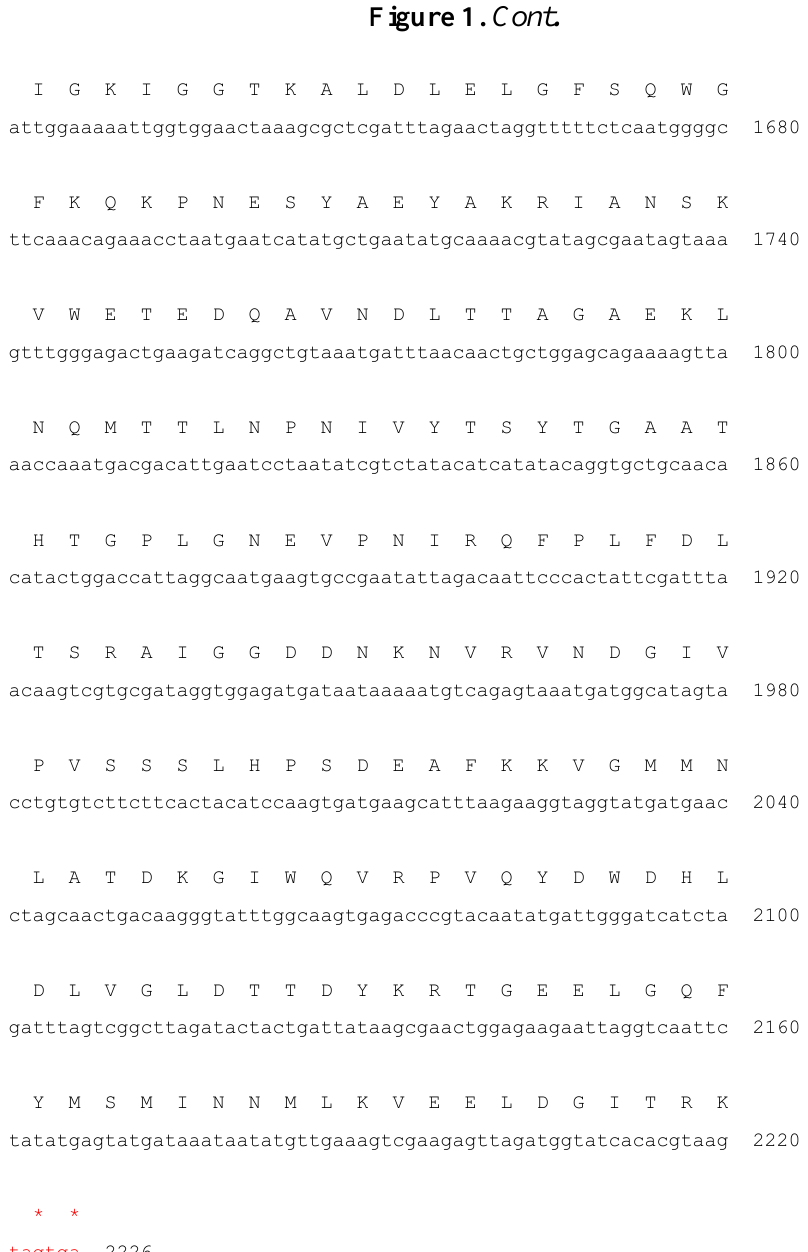
Note: The predicted promoter region (-10 and -35 promoter) and ribosome binding site (RBS) are highlighted in red and part of the mature enzymes are highlighted in yellow. The signal peptide is highlighted in blue. The pro-peptides are located in between the signal peptide and mature part. The conserved pentapeptide is highlighted in green, start and stop codon are underlined and indicated by (*), respectively. The AT2 lipase sequence has been submitted to GenBank database under the accession number